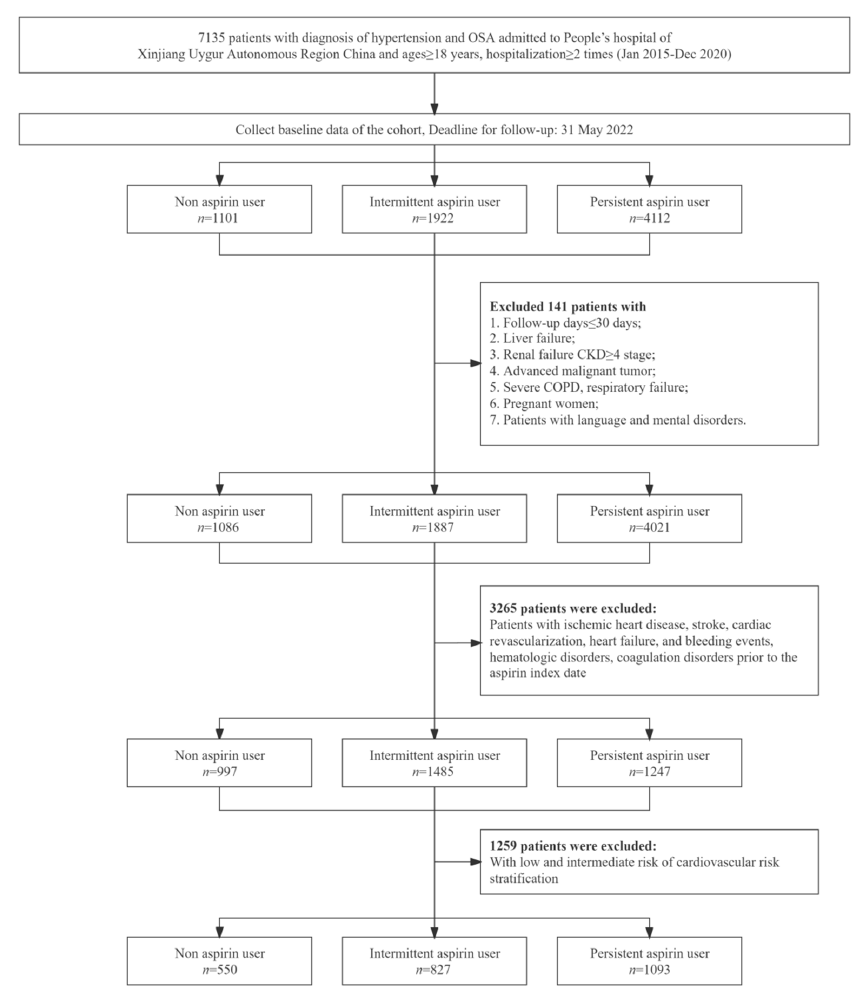
Figure 1. Participants Flowchart. Annotation: OSA, obstructive sleep apnea; CKD, chronic kidney disease; COPD, chronic obstructive pulmonary diseases.